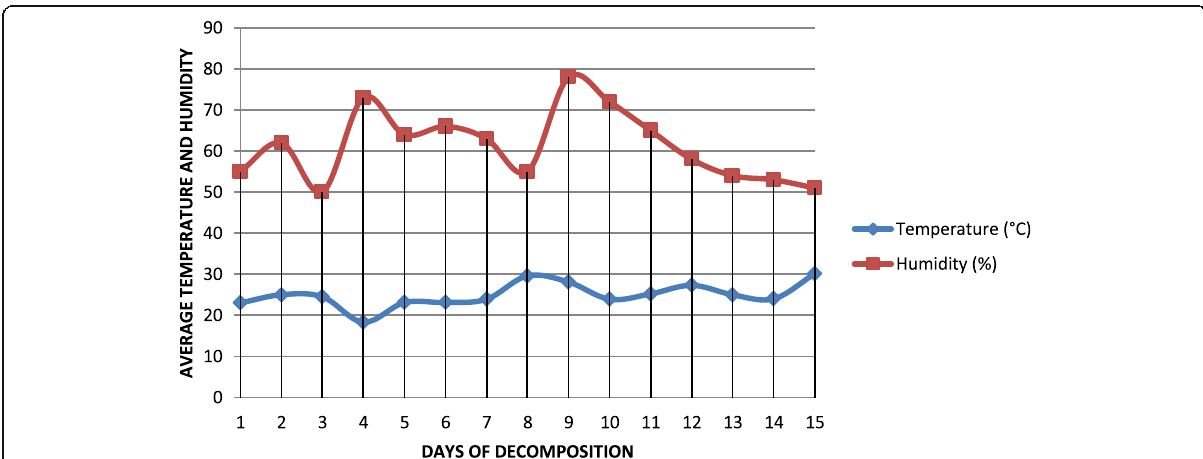
Fig. 1 Meteorological data showing average temperatures and humidity during the experiment. This figure describes the average temperature and humidity of each day during the whole decomposition